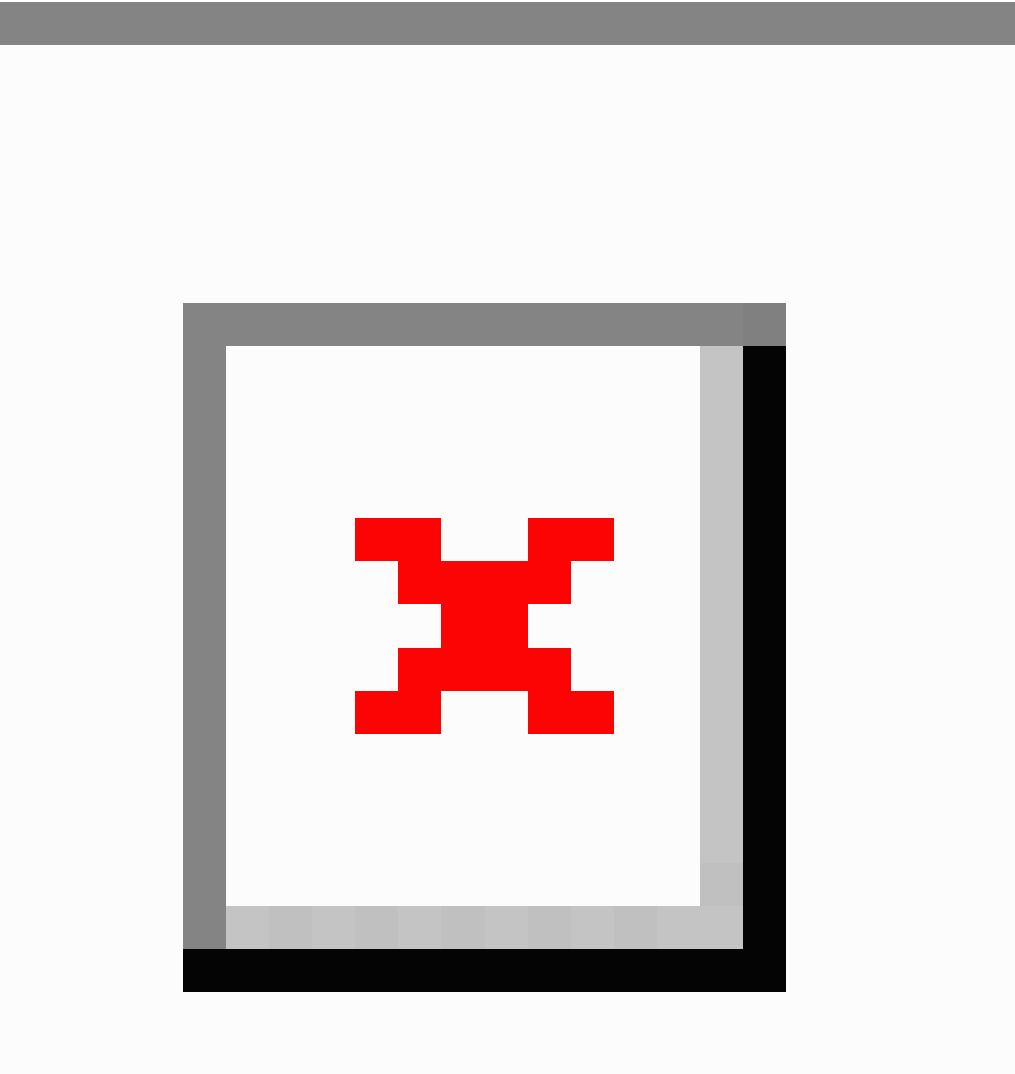
Figure 2. Map of Atlanta (gray outline) including major interstates (black lines) and selected major roads (dark red lines); points in the figure represent 79 data collection